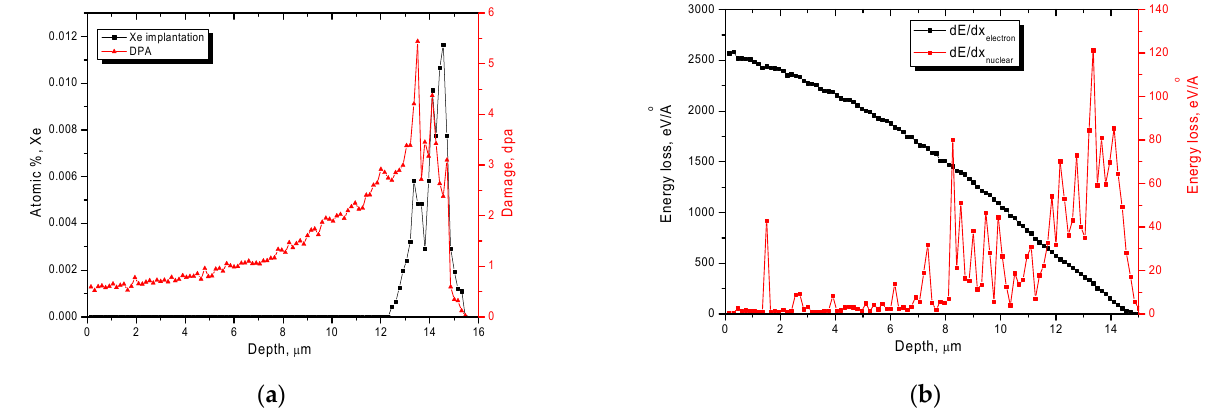
Figure 1. ( a ) Simulation results of Xe 22+ ion implantation and atomic displacement values; ( b ) simulation results of energy losses of Xe 22+ ions along the trajectory of ions in the material.